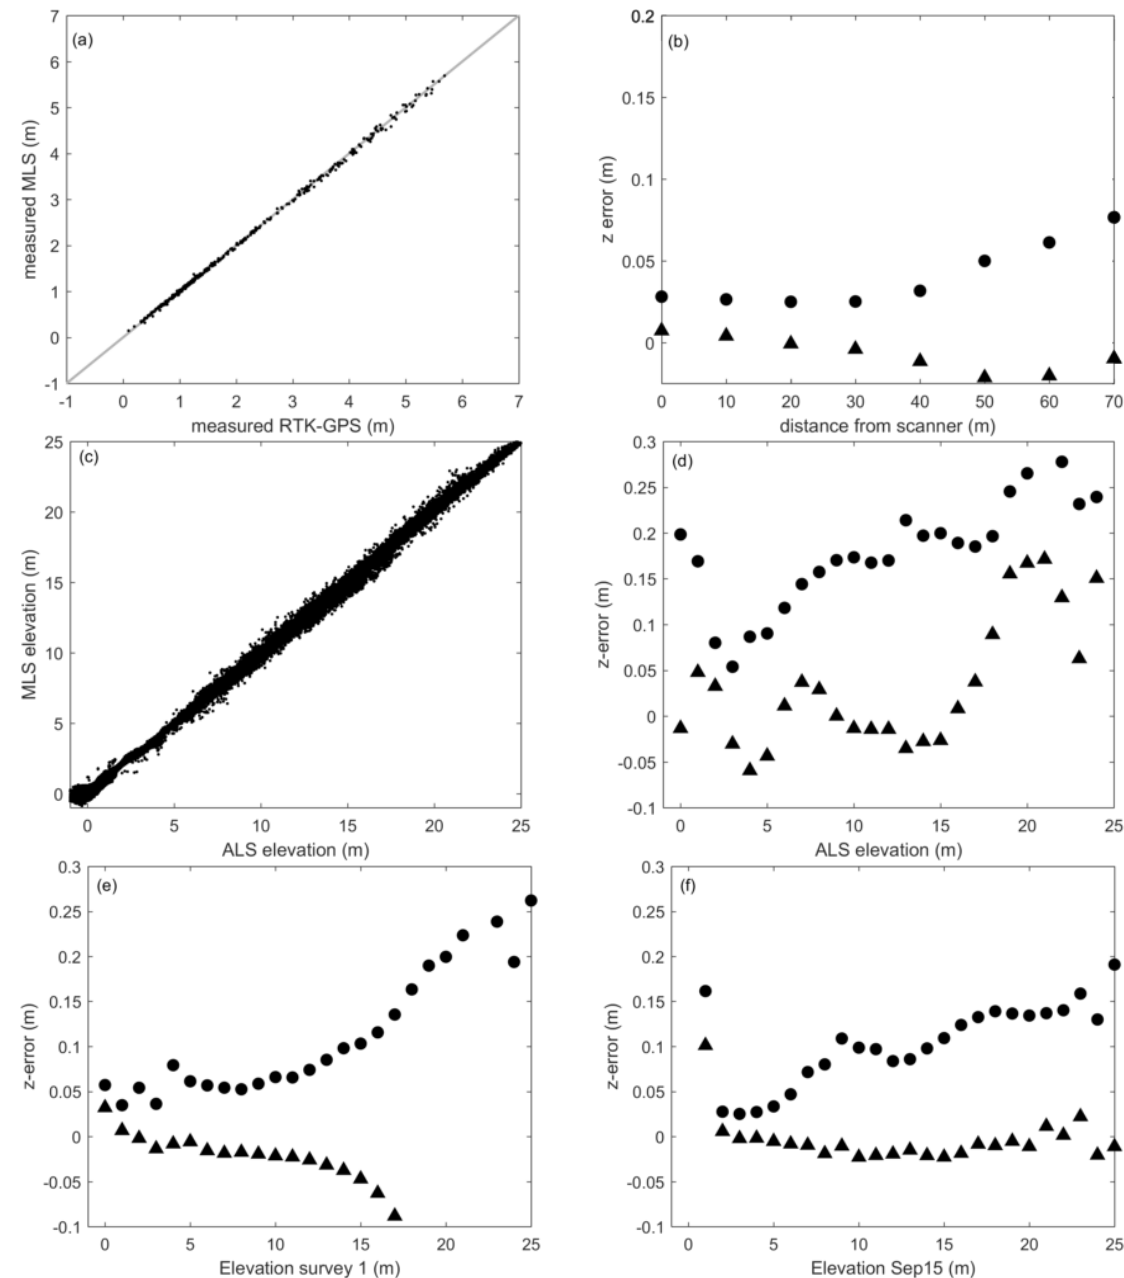
Figure 4. ( a ) Measured MLS versus RTK-GPS elevation. The grey line is the line of equality; ( b ) The average (black triangles) and root-mean-square difference (black dots) between MLS and RTK-GPS elevation taken over 10-m wide bins; ( c ) ALS (LMAR16) versus MLS DEM (Feb16) gridpoints. The grey line is the line of equality; ( c ) The average (black triangles) and root-mean-square difference (black dots) between ALS DEM and MLS DEM taken as a function of elevation; ( e ) Same as ( d ) but than for the two surveys of Dec13; ( f ) same as ( d ) but than for the Sep15 and Oct15a